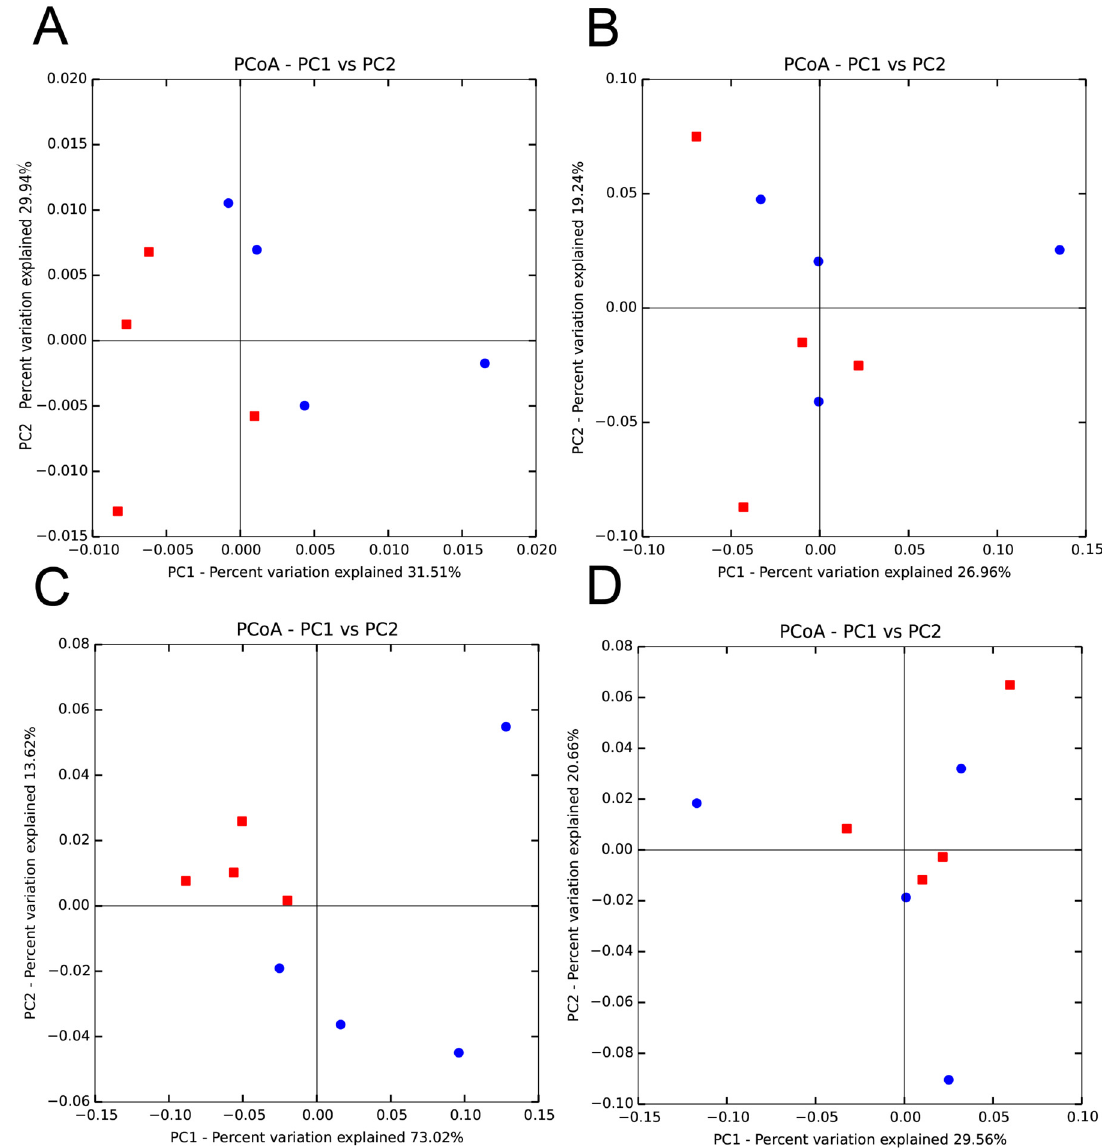
Fig 5. Principle coordinate analysis (PcoA) of the ceacum (red squares) and feacal (blue circles) microbiomes. Comparisons were carried out using both qualitative and quantitative measures of alpha and beta diversity. A) PcoA using abundance based Jaccard dissimilarity coefficient, B) PcoA using binary Jaccard dissimilarity coeffiecient, C) PcoA based on weighted UniFrac, D) PcoA based on unweighted UniFrac. The percent variation explained by each principle coordinate is